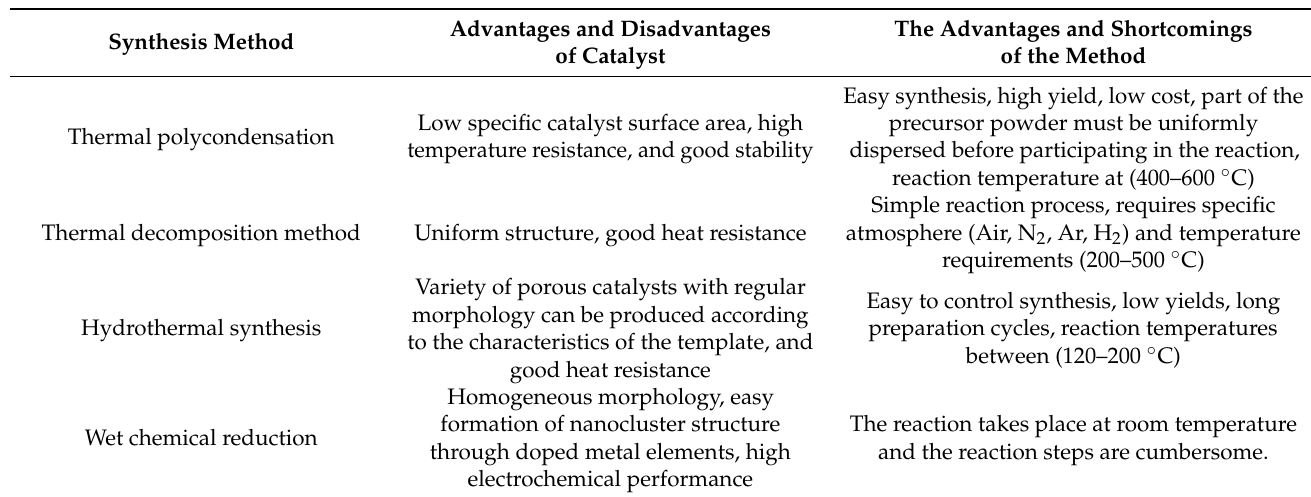
Table 8. Advantages and shortcomings of g-C 3 N 4 -based catalyst synthesis